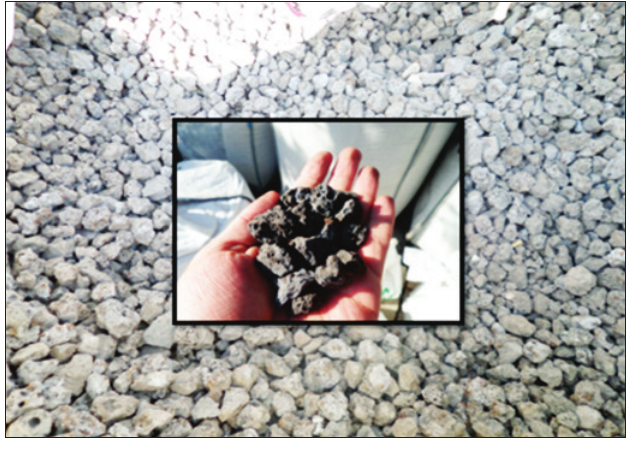
Figura 1 Agregados siderúrgicos utilizados